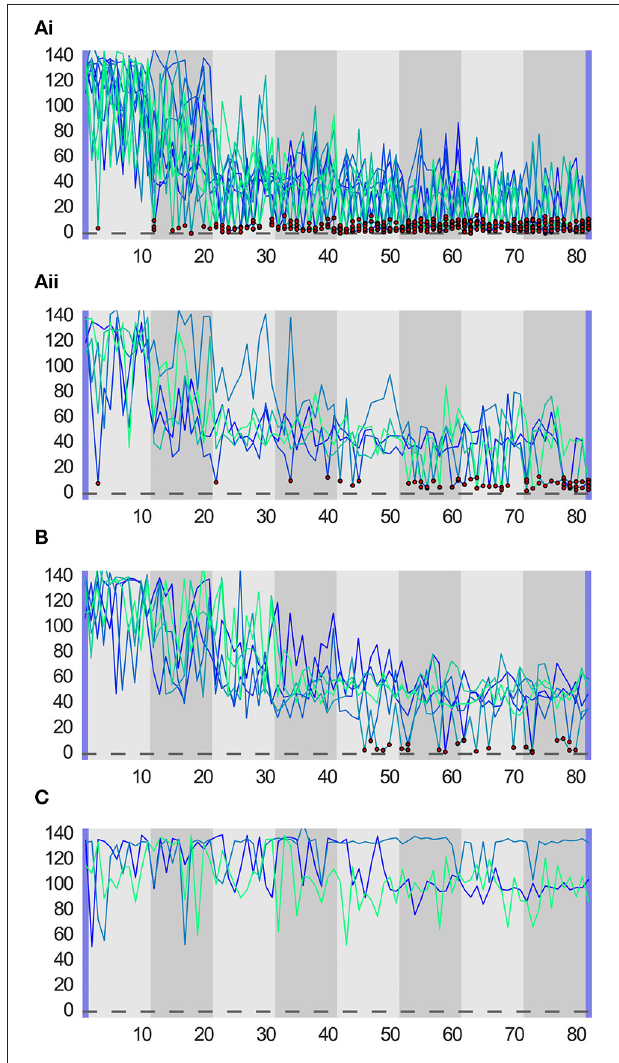
FIGURE 5 | System performance for all sessions in a success category. Each line corresponds to camera obtained ground truth (i.e., automatically detected ball to cup distance in pixels) for one session (80 rollouts). Dots mark hits. Each plot corresponds to one success category: (A.i) successful early convergence; (A.ii) successful late convergence; (B) premature convergence; and (C) unsuccessful